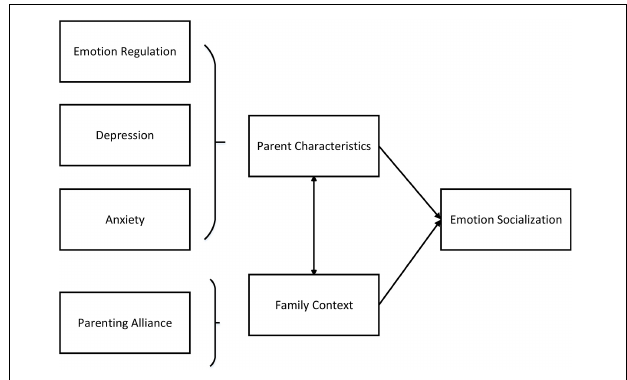
FIGURE 2 | Theoretical model of emotion